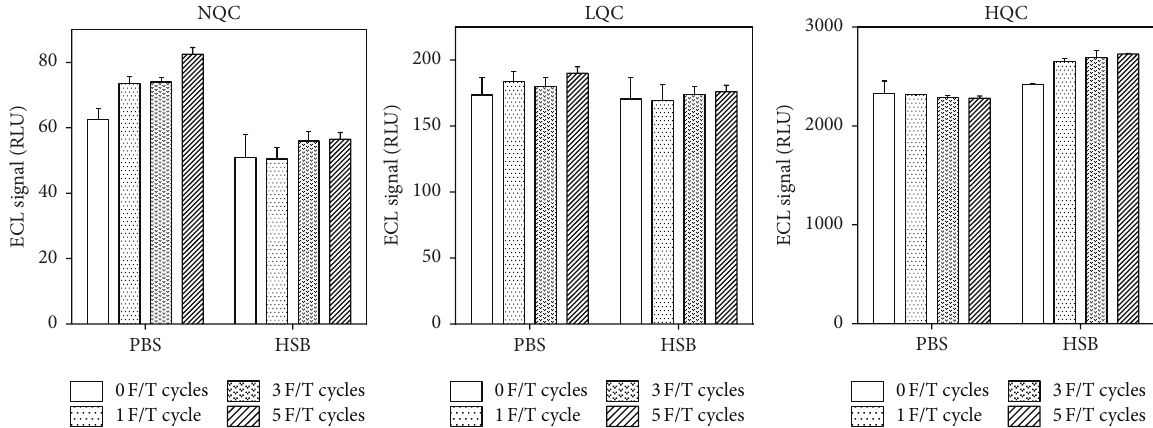
Figure 3: ECL signal in relative light units (RLU) of the system suitability controls: negative control (NQC: pooled serum) and low and high positive controls (LQC: 15ng/mL, HQC: 1000 ng/mL of affinity-purified anti-idiotype goat polyclonal antibody in NQC) analyzed with reagents stored in PBS and HSB subjected to multiple freeze-thaw (F/T) cycles. Error bars show mean with standard